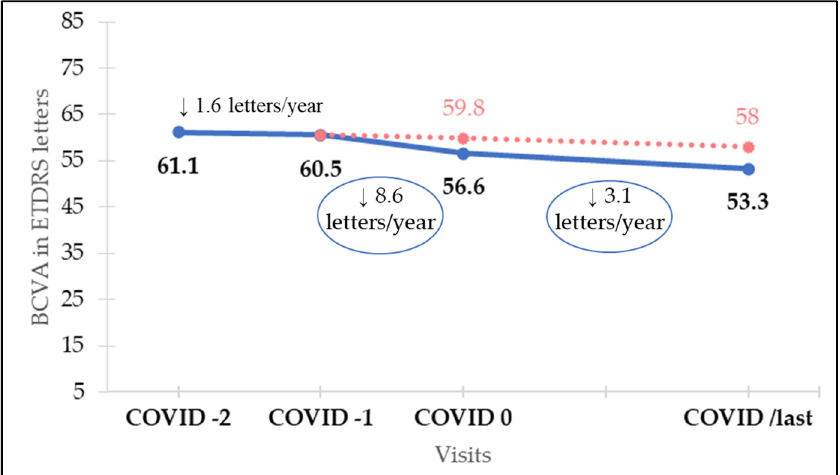
Figure 1. Rates of visual loss for each period and real (blue line) and expected (red dotted line) best corrected visual acuity (BCVA).